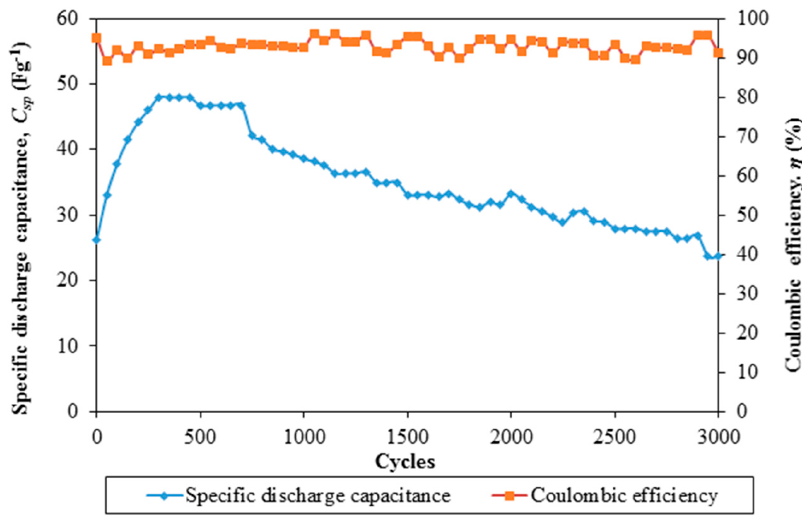
Figure 6. Specific discharge capacitance and Coulombic efficiency of Ti 3-based EDLC over 3000 cycles of charging and discharging.